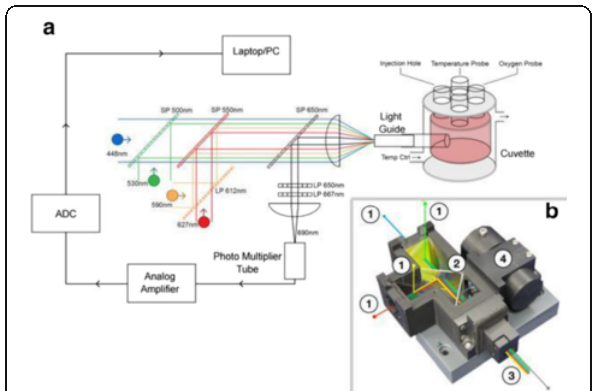
Fig. 16 (abstract A30). LED phophorimeter schematic